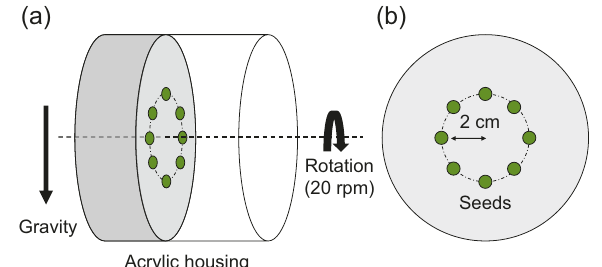
Fig. 4 Schematic illustration of clinorotation. a Side and b front views. Eight mung bean seeds were placed in an acrylic housing at a distance of 2 cm from the axis in a circle and rotated at 20 rpm for 3